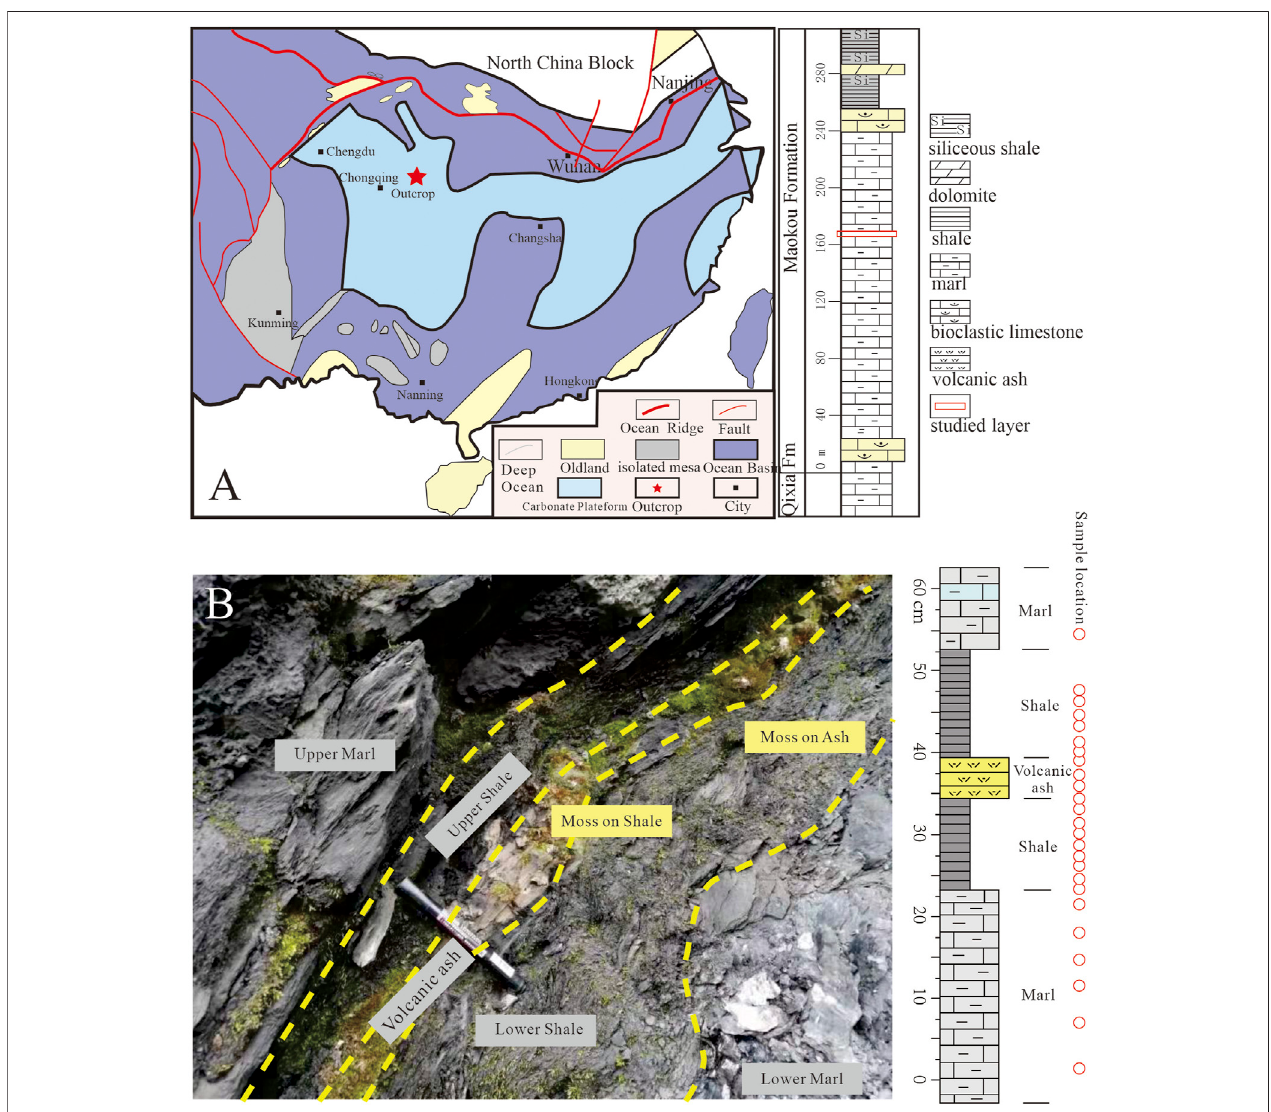
FIGURE 1 | Outcrop location (A) and the micro section composition (B) [A modi fi ed from Luo (2009)].